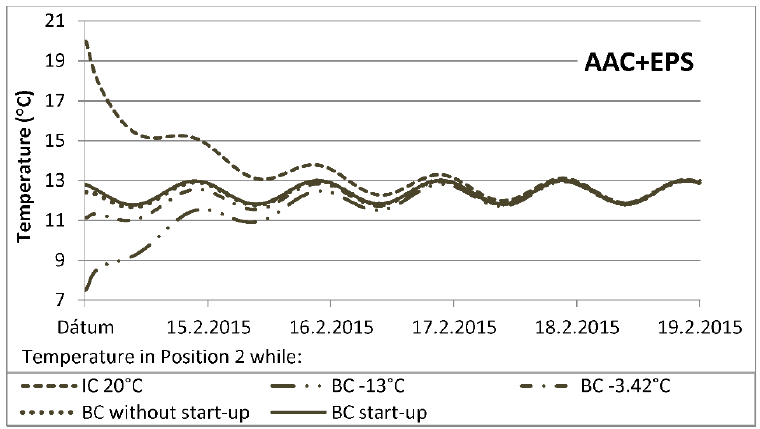
Figure 12. Plotted temperature courses of the outdoor test cell wall S1 in Position 1, according to Table 2 and Figure 5a during the chosen time period.